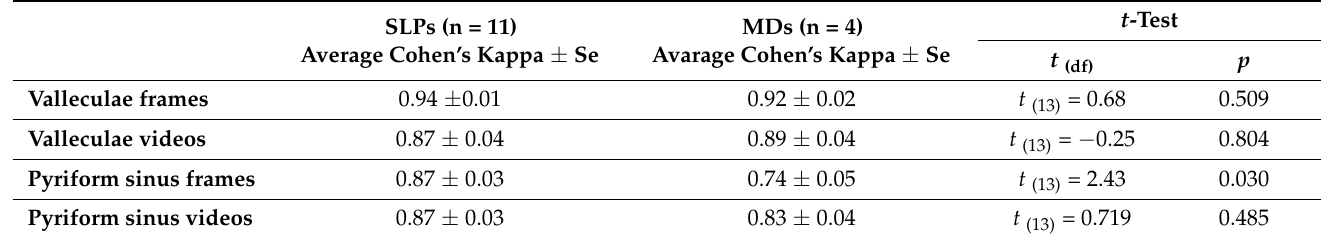
Table 7. Intra-rater in frames and videos rating across SLPs group and MDs group.